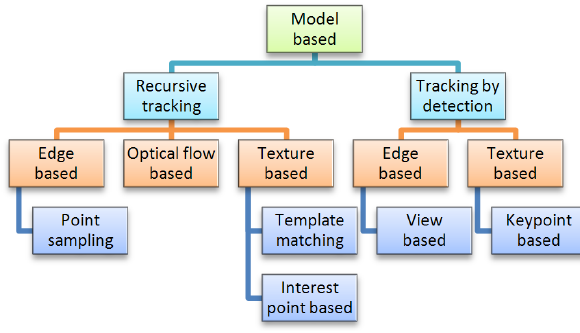
Figure 4. Model based online monocular markerless AR